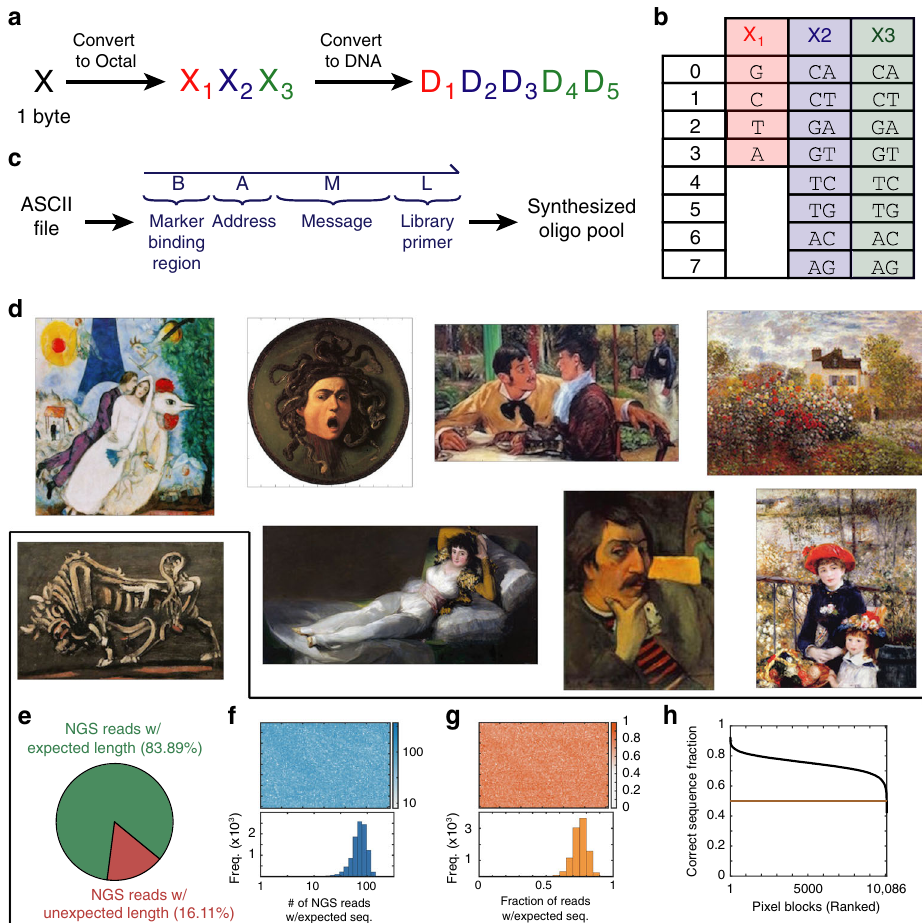
Fig. 3 Encoding ASCII fi les as DNA. The artworks used are low-resolution images freely available for reuse under the terms of a Creative Commons license or that are marked as being in the Public Domain. a We encode each byte as a word of 5 DNA nucleotides. The mapping is 80% ef fi cient compared to the minimum 4 nt needed to encode 256 possible characters. b Mapping table. Importantly, this mapping restricts G/C content of DNA sequences to between 40% and 60%, and guarantees that there are no homopolymer stretches of more than 3 nt. c Each DNA oligonucleotide used for information storage can be abstracted as four domains. The B region is a 25 nt sequence common to all oligos, in which the truth marker and false marker can bind. The A region corresponds to the address of the message, relative to a fi le position, and is 10 nt in length. The M region corresponds to the message content and is 60 nt in length. The L region corresponds to a 25 nt library-speci fi c primer sequence used for preampli fi cation from chip-synthesized oligo pools; the L region is removed in the fi nal oligos used for storage. d Bitmap images of eight pieces of artwork encoded as DNA. Displayed here are the reconstituted images based on the designed oligo pool synthesized by Twist Biosciences, read via NGS on an Illumina MiSeq. See Supplementary Note 4 for additional details. e Distribution of NGS reads that have the expected length. The 16.11% of NGS reads with unexpected lengths are typically shorter and are due to oligo synthesis truncations or sequencing error, and were excluded from further analysis. f Spatial distribution of sequencing depth. g Fraction of NGS reads mapping to the exact expected sequence for each pixel block, based on position. h Fraction of NGS reads mapping to the exact expected sequence for each pixel block, sorted by rank. 0.19% of the pixel blocks in this image had the intended NGS read sequence occupying below 50% of the reads at the address, indicating potential poor oligonucleotide synthesis Encoding bitmap images in DNA . Figure 3a shows our sche- For our demonstrations in this paper, we encoded bitmap me for encoding standard ASCII data in DNA; each byte is images of famous artwork. Each pixel in the image corresponds to converted into a 5 nt DNA string via the lookup table on 3 bytes of information, one byte each for Red, Green, and Blue Fig. 3b. This encoding is designed to facilitate DNA synthesis: intensity, or 15 nt. Each DNA oligonucleotide (oligo) used for all DNA sequences will have GC content between 40% and encoding information is 120 nt long, and comprises four distinct 60%, and no DNA sequence will have any nucleotide homo- regions (Fig. 3c): the truth marker binding region B (25 nt), the polymers of more than 3 (see Supplementary Note 3 for address A (10 nt), the message M (60 nt), and the library primer L details). In our oligonucleotide pool of 93,894 distinct (25 nt). Each message M corresponds to a 2 × 2 block of pixels, sequences, none triggered synthesis warnings, so we believe and each address speci fi es the X and Y coordinates of the pixel that the encoding successfully accomplishes its task of facil- block. The 93,894 DNA oligos in the pool were used to encode itating synthesis. Simultaneously, the encoding is 80% ef fi cient the eight images shown in Fig. 3d. Because the initially from an information density perspective (encoding 8 bits with synthesized pool was very low in total quantity, we individually 10 bits), resulting in only a minor loss of information storage ampli fi ed different subpools via the image-speci fi c library primer density. sequences (see Supplementary Note 4 for details).